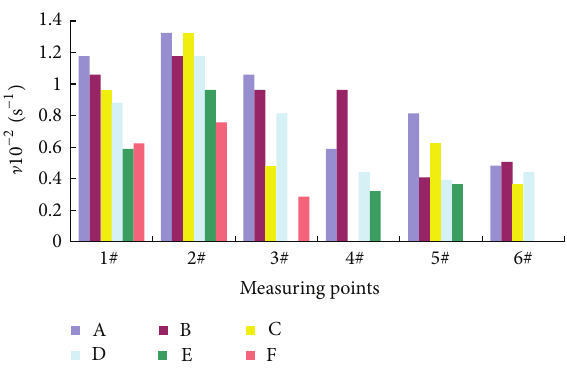
Figure 4: The change rate of the nitrogen concentration ] .